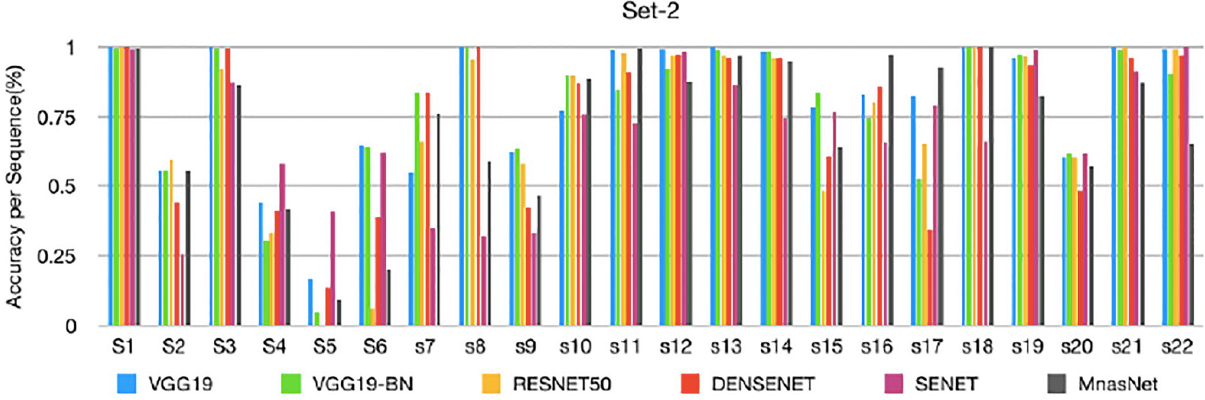
Fig 6. Sequence-based performance of set-2: The performance of different models for each test sequence of set-2.